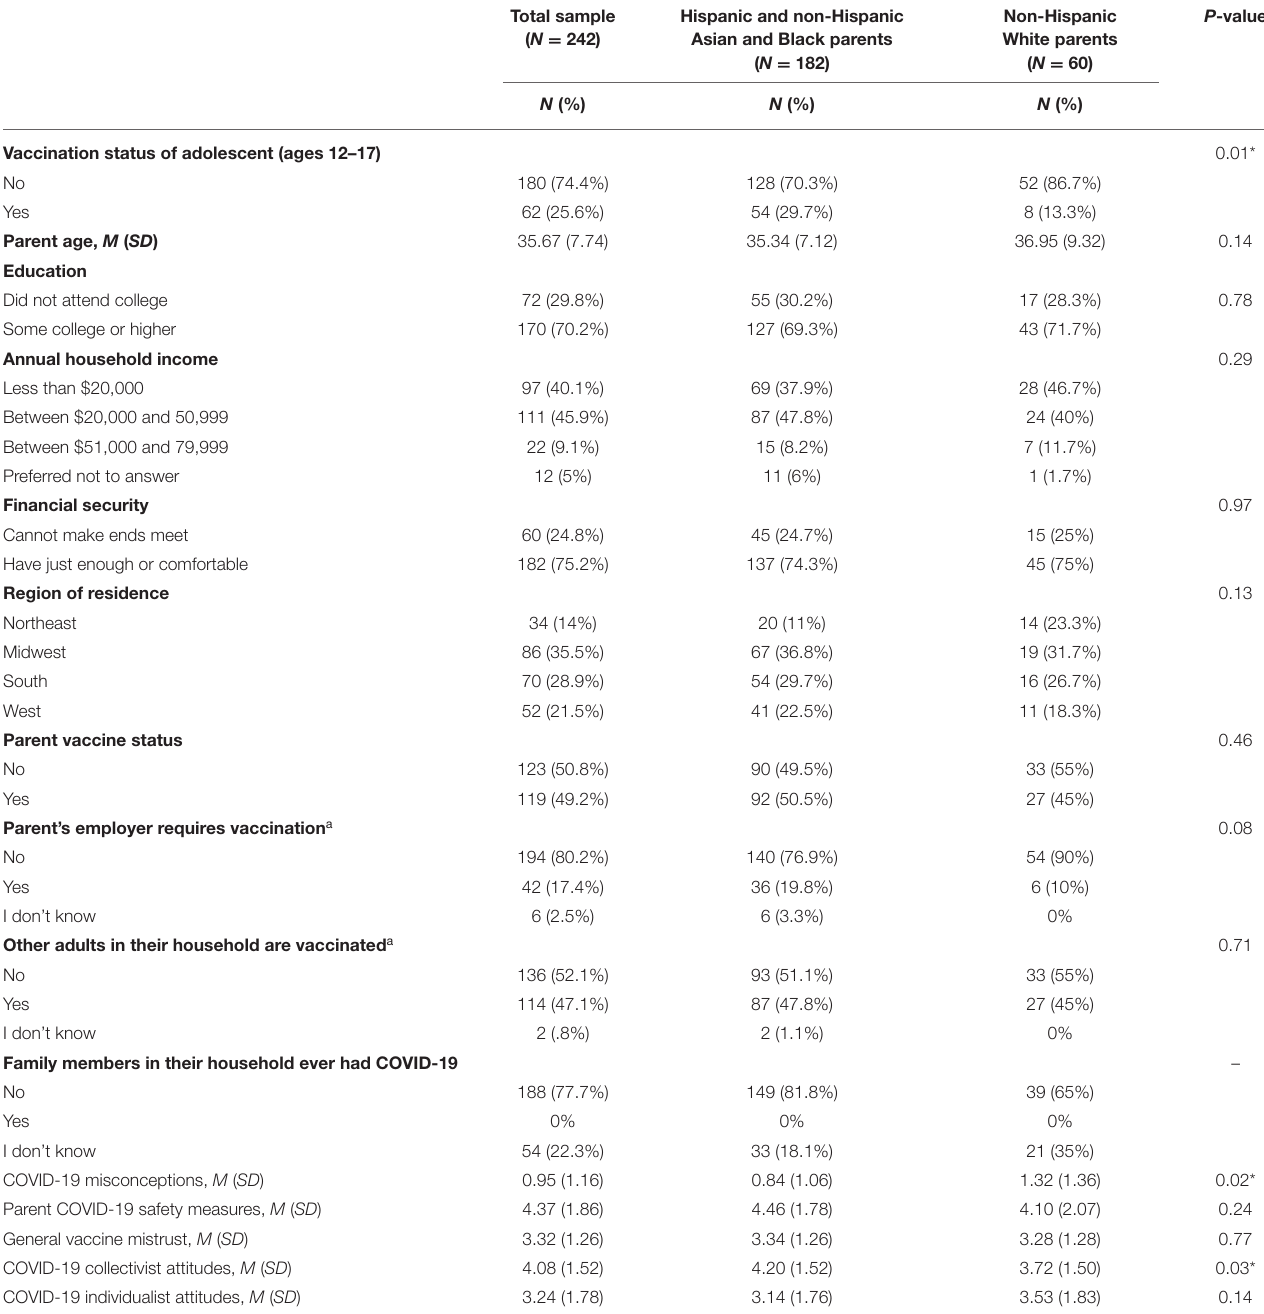
TABLE 2 | Frequencies/percentages and means/standard deviations for racial/ethnic group differences in adolescent vaccination status and parent characteristics.